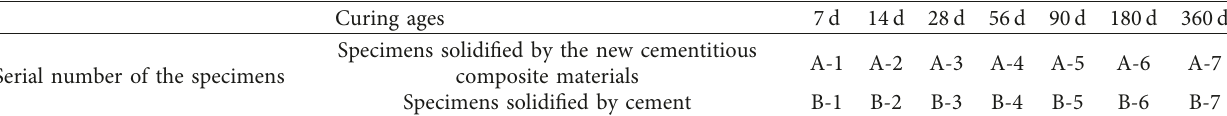
Table 5: Details of specimens.